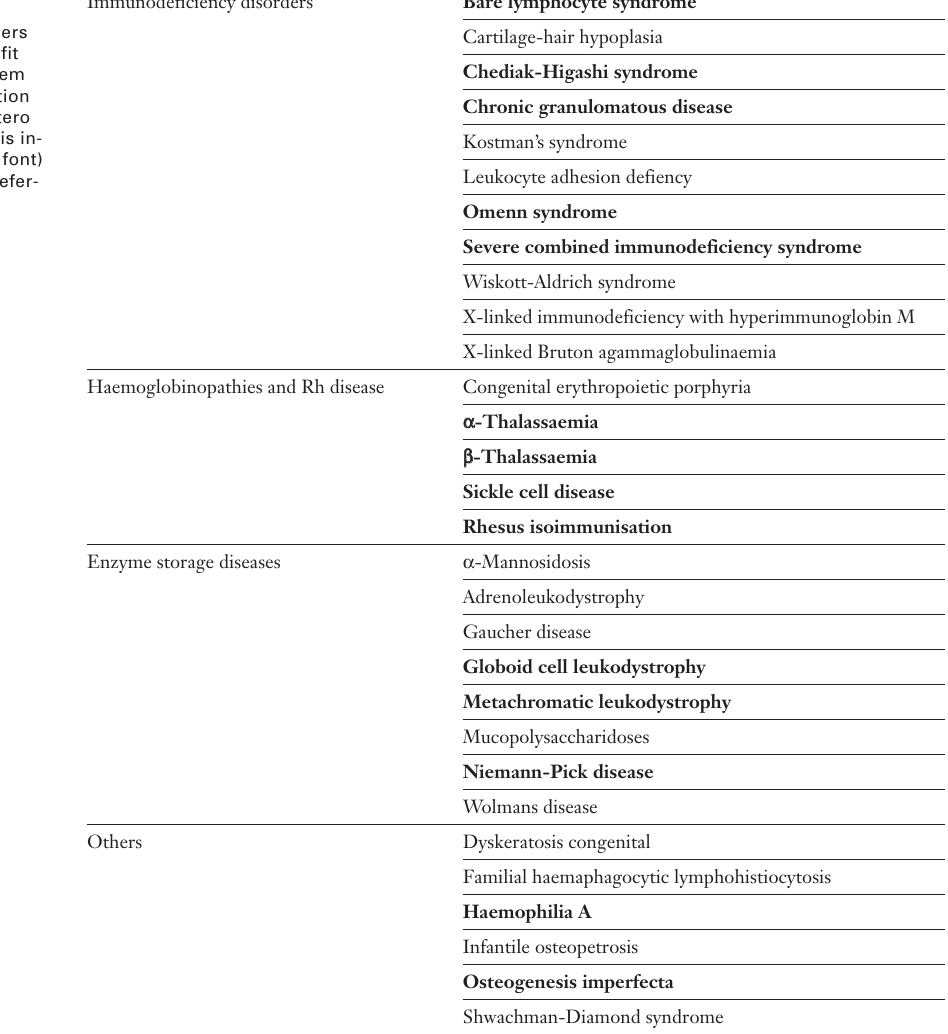
Inherited disorders that might benefit from in utero stem cell transplantation (attempted in utero transplantation is in- dicated by bold font) [adapted from refer- ence